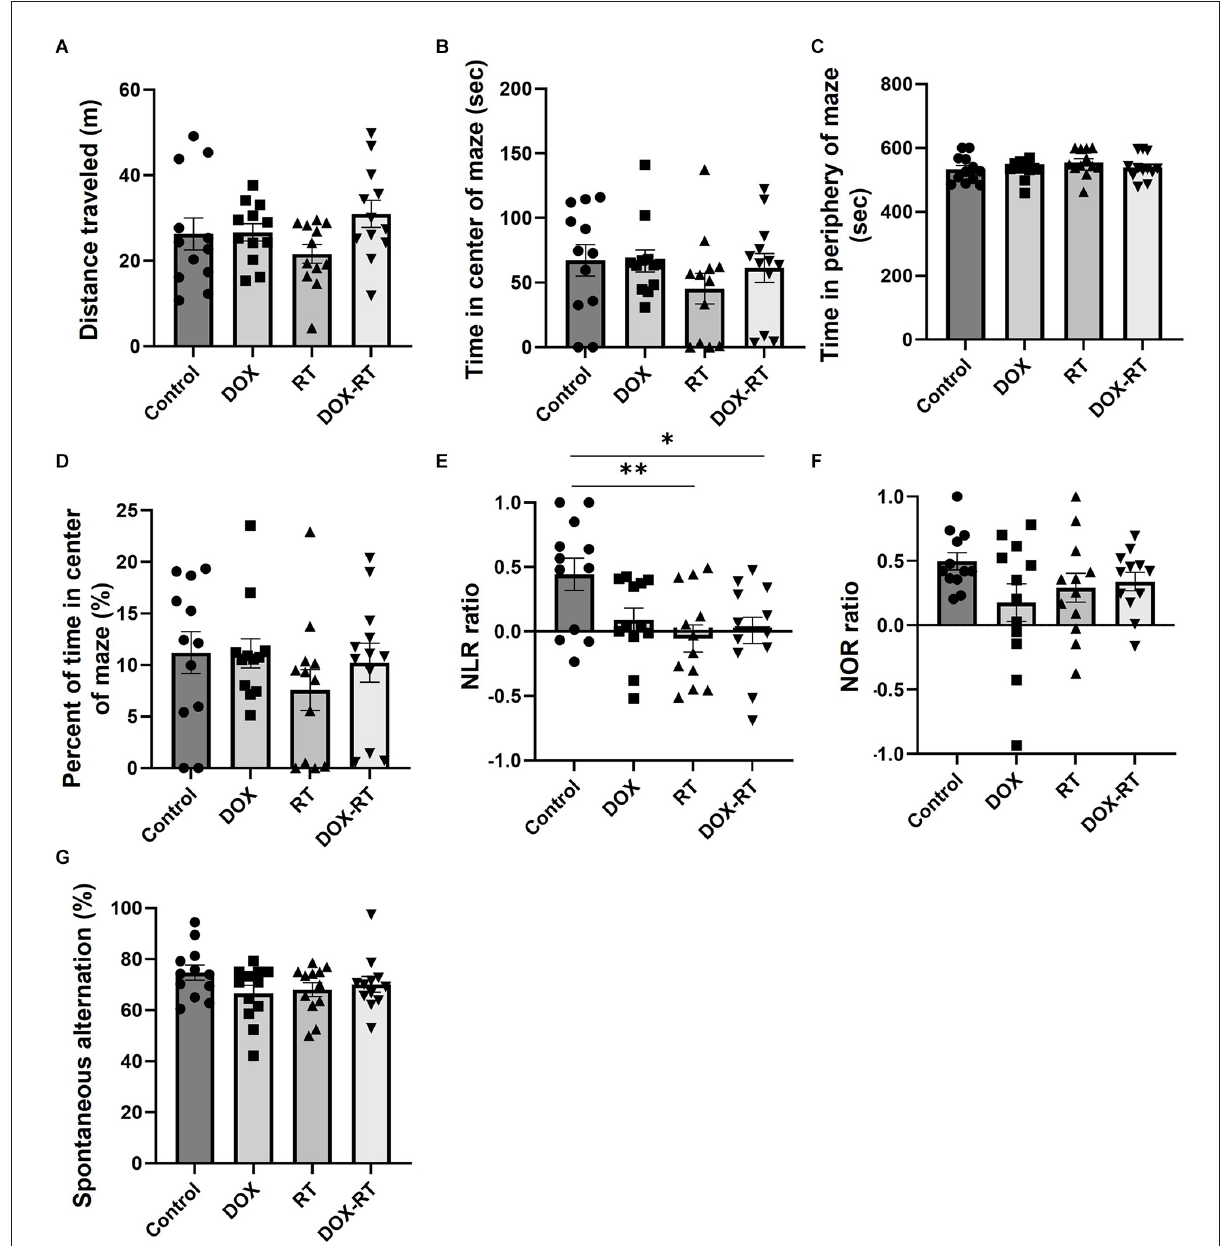
FIGURE2 Cancer treatment causes hippocampal dependent memory deficit in mice. (A) Open field test did not detect a difference between groups in the total distance traveled. (B) Open field test did not detect a difference between groups in time spent in the center of the maze. (C) Open field test did not detect a difference between groups in time spent in the periphery of the maze. (D) Open field test did not detect a difference between groups in percentage of time spent in the center of the maze. (E) Novel location testing showed that RT and DOX-RT mice had a significantly lower discrimination ratio than control mice. (F) Novel object recognition test did not detect a difference in discrimination ratio between groups. (G) Spontaneous alternation y-maze testing showed a similar percentage of alternations between groups. Data represent the mean and SEM ( n = 12 per group). DOX, doxorubicin group, RT, hindlimb radiation group, DOX-RT, doxorubicin and hindlimb radiation group. Discrimination ratio = (time spent investigating changed object − time spent investigating unchanged object)/(time spent investigating changed object + time spent investigating unchanged object). Spontaneous Alternation percentage (%) = number of spontaneous alternations/(total number of arm entries − 2) × 100. One asterisk ( ∗ ) representing p -value < 0.05 and two asterisks ( ∗∗ ) representing p -value <